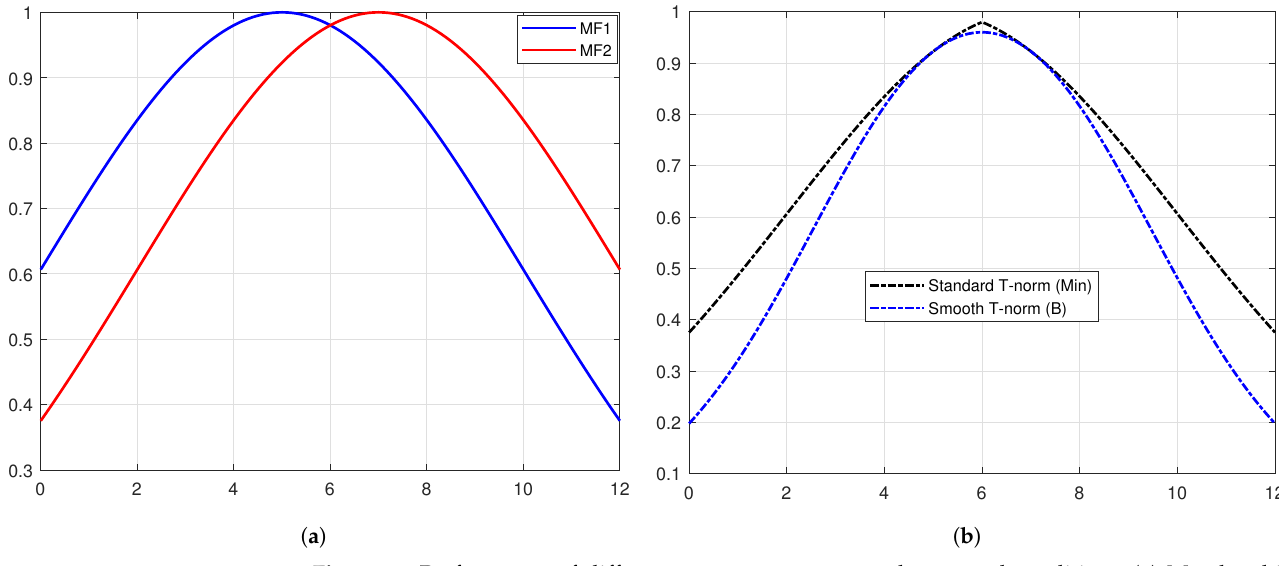
Figure 1. Performance of different t-norm operators under normal condition. ( a ) Membership Functions. ( b ) Output of Fuzzy